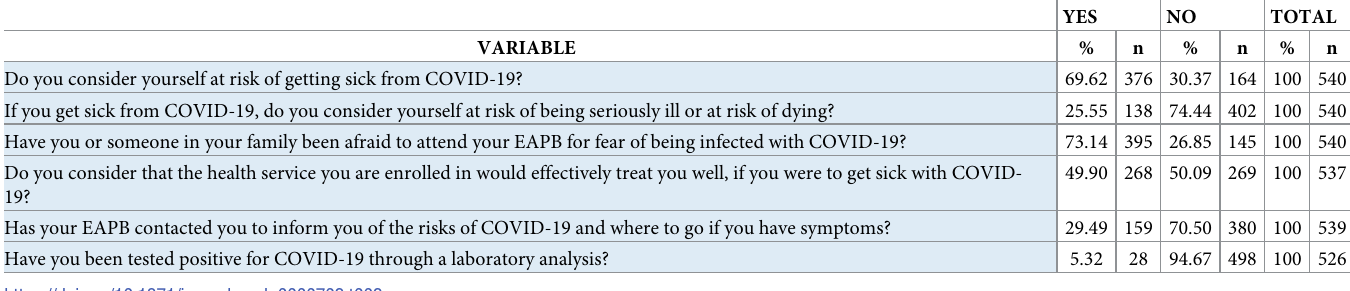
Table 2. Information received about